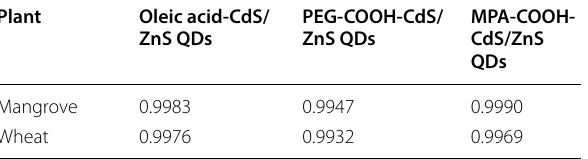
Table 1 Nanosecond time-resolved fluorescence spectra correlation coefficient ( R 2 ) for the three-way PARAFAC model